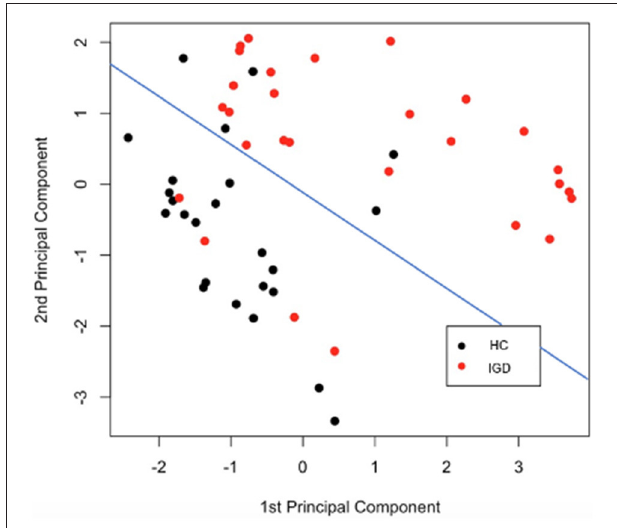
FIGURE 7 | Kernel PCA using combined kernel. HC, healthy control; IGD, internet gaming disorder.